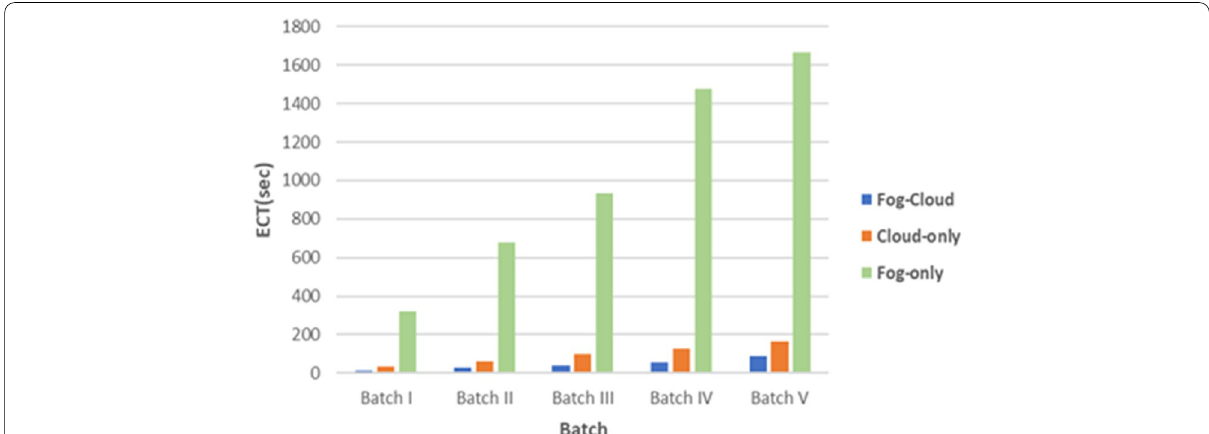
Fig. 9 ECT v/s batch size for IJFA for fog integrated cloud, cloud-only and fog-only